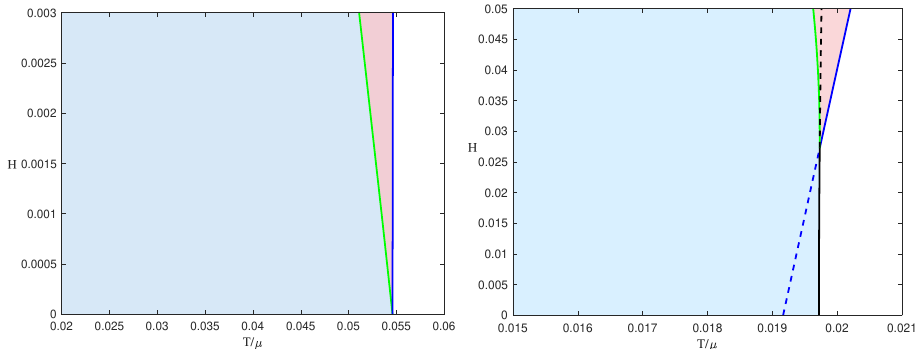
Figure 4 . The H − T phase diagrams with b = 0 . 3 (left plot) and b = 0 . 68 (right plot). The region colored light blue, light red and white denote the p-wave phase, the p+ip phase and the normal phase, respectively. The solid blue line denotes the critical points of second order phase transition between the normal phase and the p+ip phase, the solid green line denotes the first order phase transition points between the p+ip phase and the p-wave phase. In the right plot, the solid black line denotes the first order phase transition points between the normal phase and the p-wave phase, and the dashed part of the blue line denotes the “critical point” of the p+ip solution if the p-wave solution is not included. The tricritical Point in the right plot is ( T t = 0 . 01973 , H t = 0 . 02720)